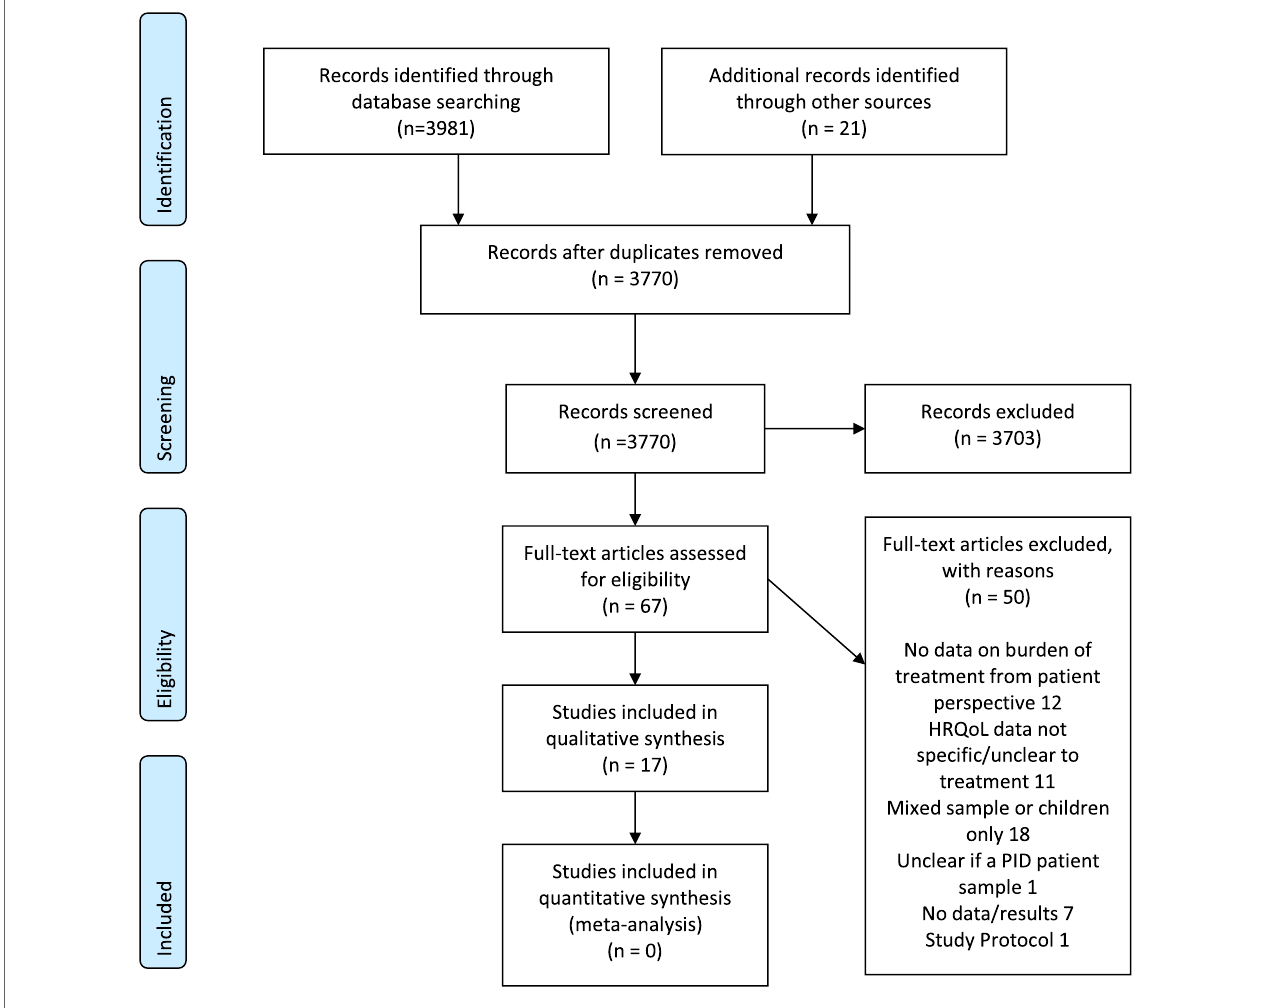
FigURe 1 | PRISMA 2009 flow